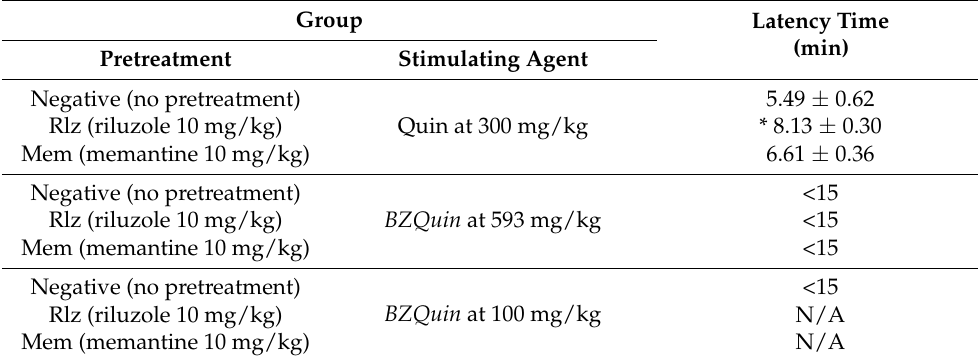
Table 1. Latency time until the occurrence of the first Racine stage of immobility. The latency time was accounted for during the first 15 min after the administration of the stimulating agent and corresponded to the arithmetic means and SEMs of each group.